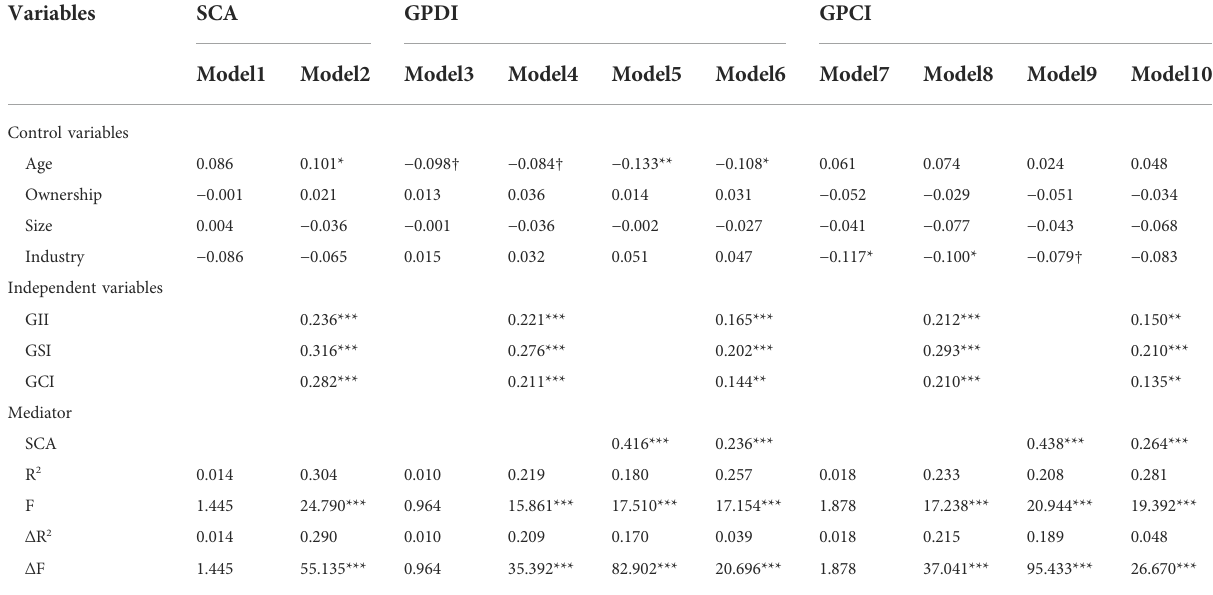
TABLE 4 Results of regression